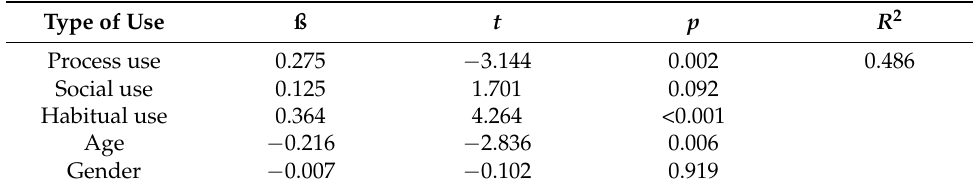
Table 3. Predictors of PSU ( N =